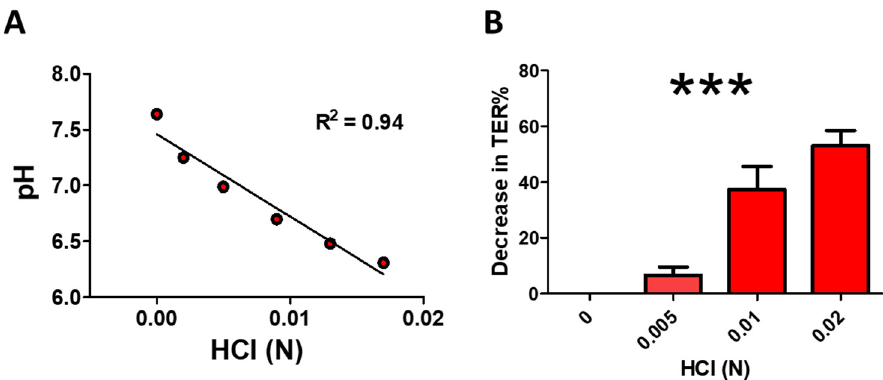
Figure 1. Hydrochloric acid (HCl) elicits a concentration-dependent decrease in pH ( A ) and trans- endothelial resistance (TER); ( B )). Line in ( A ) represents linear regression analysis (***: p < 0.001; Pearson R 2 coefficient 0.94). The maximal decrease in TER in ( B ) was plotted as a percentage of the basal resistance in the absence of HCl ( n = 3, means ± SEM; ***: p < 0.001, one-way ANOVA with Tuckey’s).